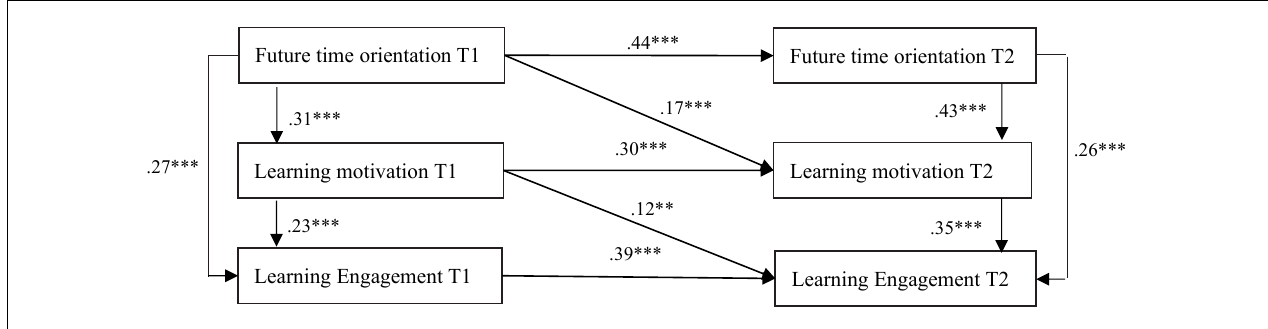
FIGURE 2 | Cross-lagged effect test. *** p <